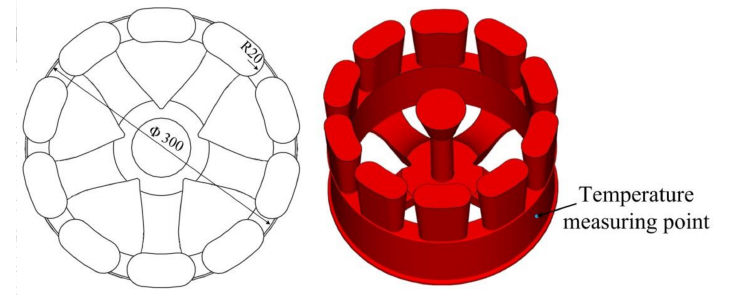
Figure 7. The wheel hub specimen geometry.